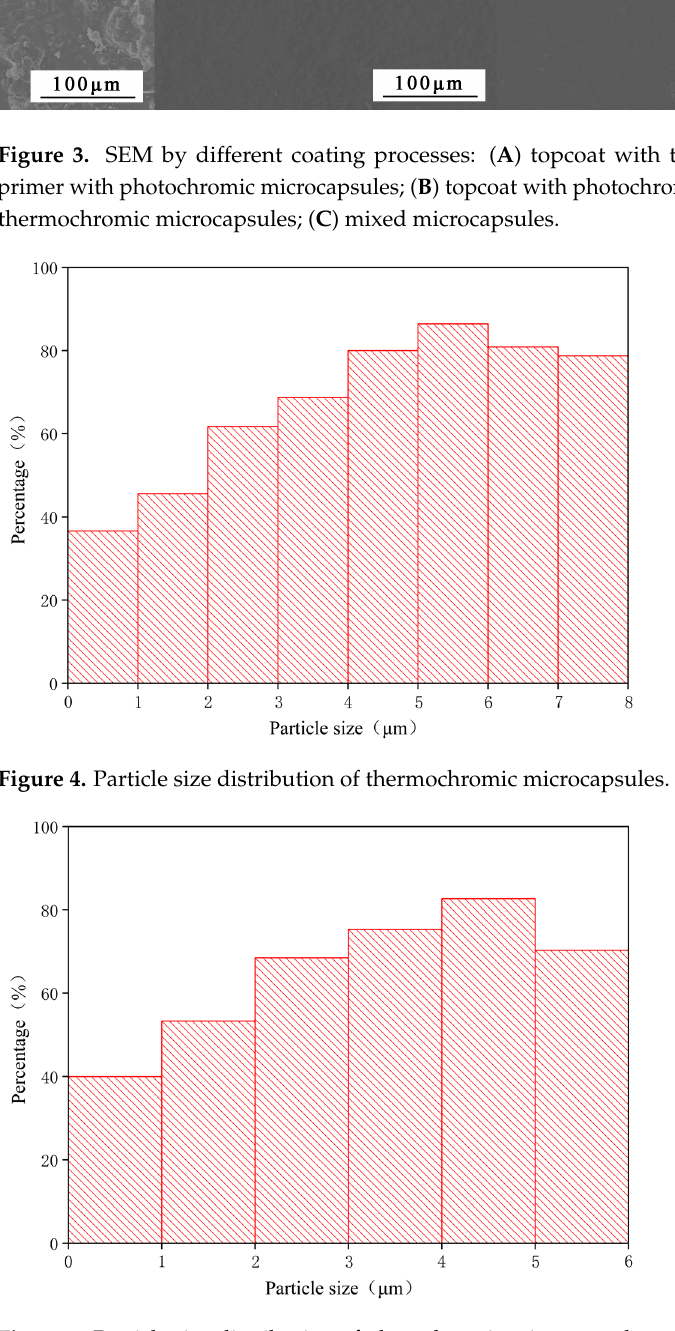
Figure 5. Particle size distribution of photochromic microcapsules.